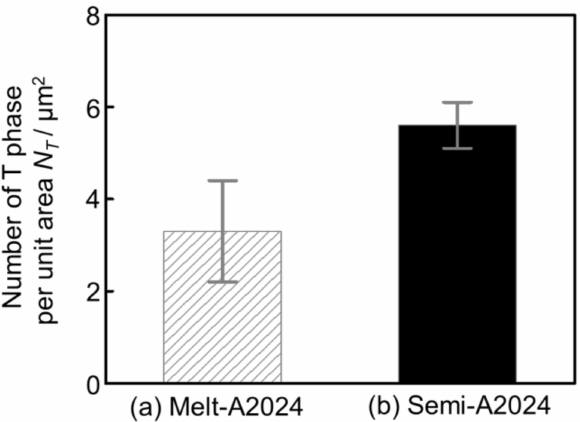
Figure 16. Number of T phases per unit area N T : ( a ) Melt-A2024; ( b ) Semi-A2024. The error bars show the standard